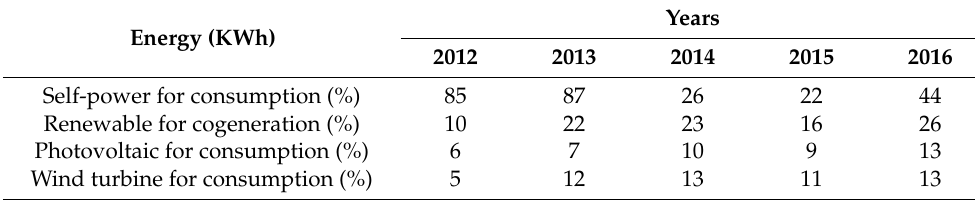
Table 2. Relative total energy balance analysis.